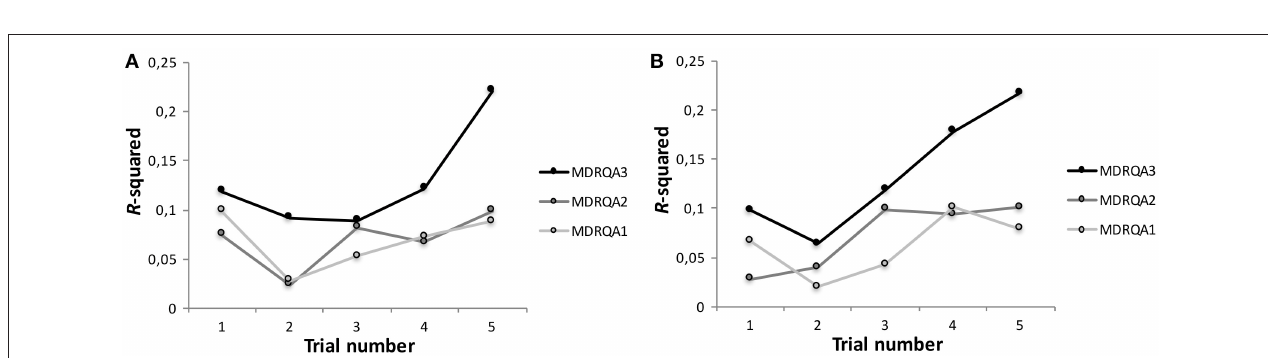
FIGURE 6 | Multivariate JPR obtained by joining the individual RPs from Figures 3H–J (A). MdRP from Figure 3K (B) . The plots convey a similar qualitative picture of the dynamics of the Lorenz system, with the main difference that the JRP has fewer points and fewer diagonal structures than the MdRP.